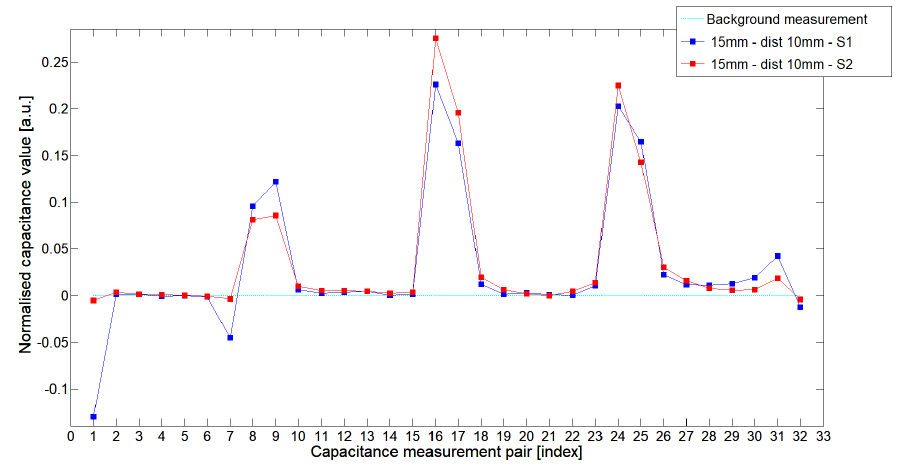
Figure 20. The 1st electrode measurement cycle (S1: 1->32 and S2: 1->32) for Test15 P 3 and S1—blue line, S2—red line. Cyan line indicates lower calibration limit.